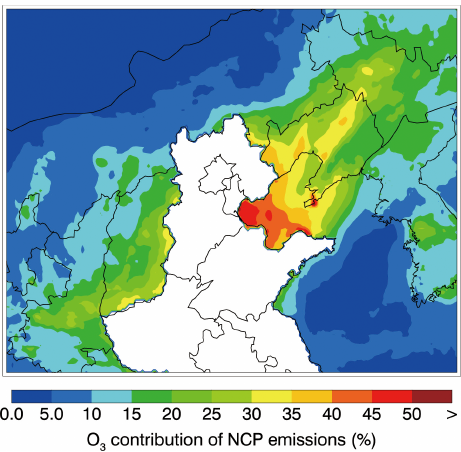
Figure 12. Same as Fig. 10, but for the afternoon (12:00– 18:00BJT) O 3